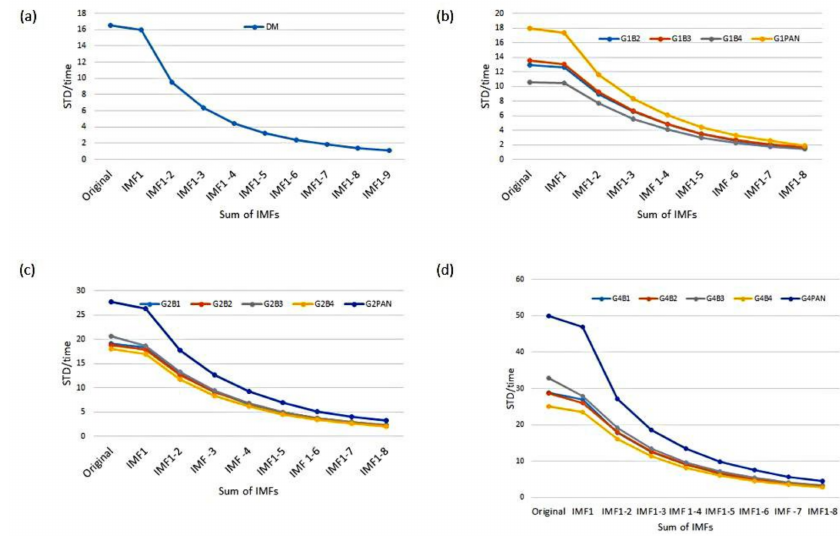
Figure 11. Statistics of the mean STD after temporal density calibration. STD/time denotes the STD calculated after the temporal density calibration. x is the number of accumulative IMFs; IMF1– x stands for the sum of x IMFs deducted from the original grayscale values. DM stands for digital mode sensor; G1B2 stands for gain setting G1 and Band 2, etc. ( a ) For digital mode (DM) test imagery before and after the correction of the sensor; the lowest mean STDs are with IMF1–9; ( b ) for flying mode test imagery before and after the correction for all bands of gain setting G1; the lowest mean STDs are with IMF1–8; ( c ) for flying mode test imagery before and after the correction for all bands of gain setting G2; the lowest mean STDs are with IMF1–8; ( d ) for flying mode test imagery before and after the correction for all bands of gain setting G4; the lowest mean STDs are with